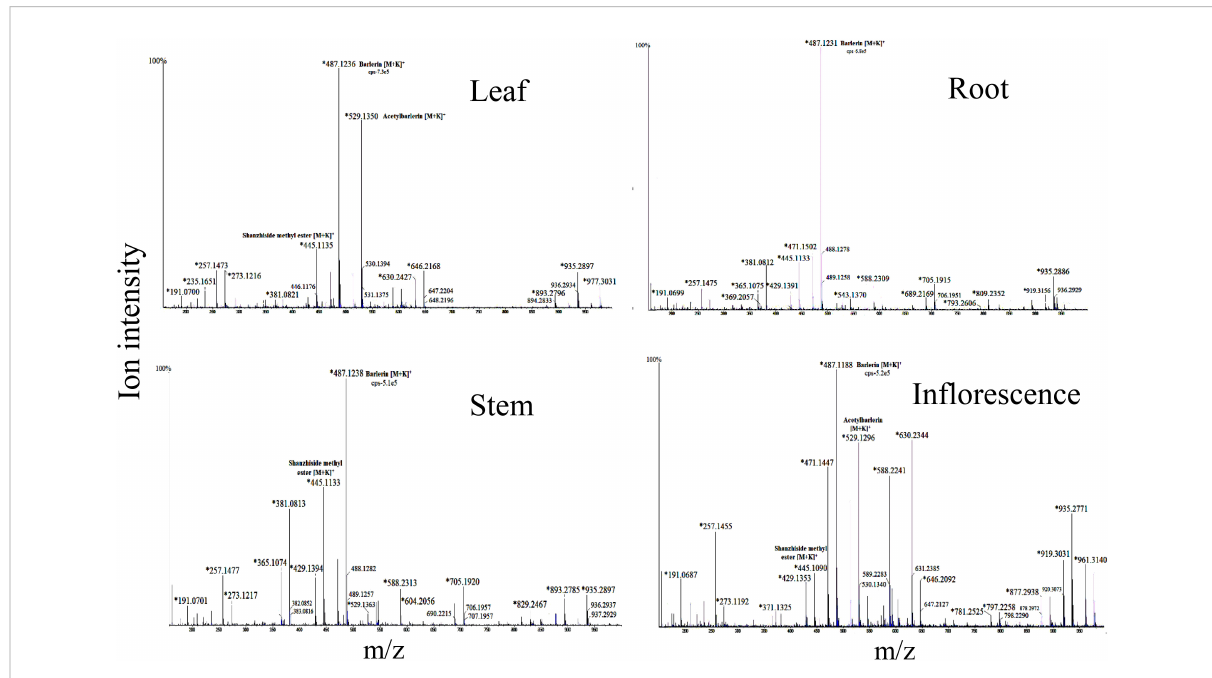
FIGURE 2 Mass spectra of root, leaf, stem and in fl orescence of Barleria prionitis showing MS1 ions in positive ion mode. Ions marked with asterisk (*) symbol are the parent ion and without the symbol are their